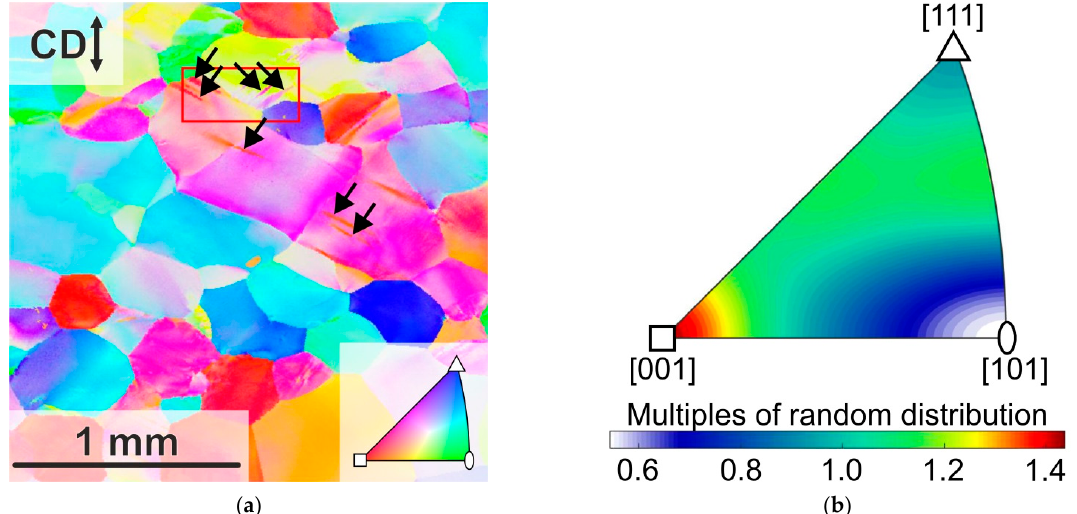
Figure 4. Microstructural analysis of compression deformed HfNbTaTiZr ( T = 298 K, ε pl , stop = 9.8%): ( a ) Color-coded orientation map on a longitudinal section shows grains of the bcc solid solution phase; compression direction (CD) is vertical, and the color code corresponds to the inverse pole figure (IPF) in the inset. Black arrows highlight kink bands. Microstructural details within the red rectangle are analyzed in an enlarged view in Figure 5. ( b ) Color-coded orientation distribution of the CD in an IPF determined from the orientations as shown in the map of ( a ).